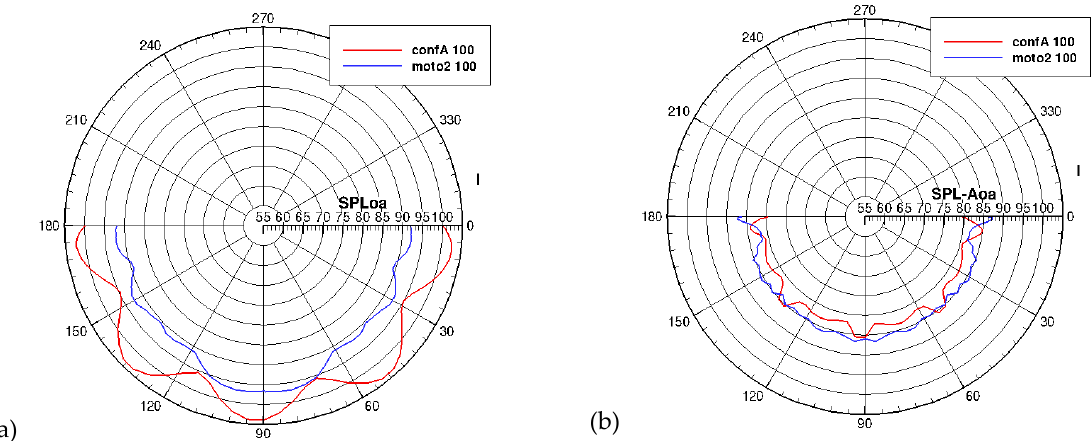
Figure 29. Comparison between Configuration A and Motorization 2; OASPL values on the transverse YZ plane ( a ), A-weighted values on ( b ). Flight condition Climb 100% ETR.